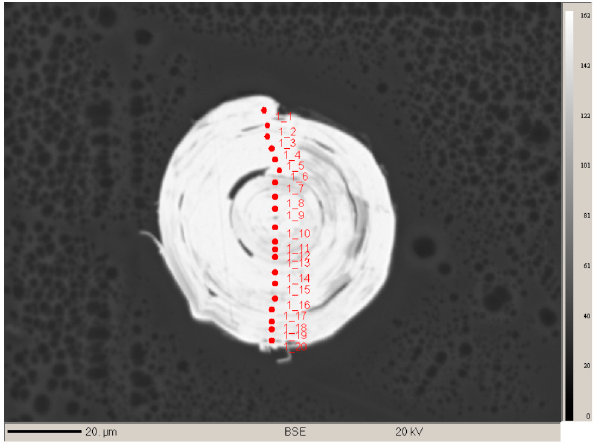
Figure 9. Polished axial section of a merelaniite “whisker” used for chemical analysis. The red spots indicate the areas analyzed across the transect. Note the scroll-like form and the clear voids between the individual layers which are attributed to have led to the weight% totals being a little under 100%. Sample BM 2016,100; probe block P19396. Table 2. Chemical data (wt %) for merelaniite.